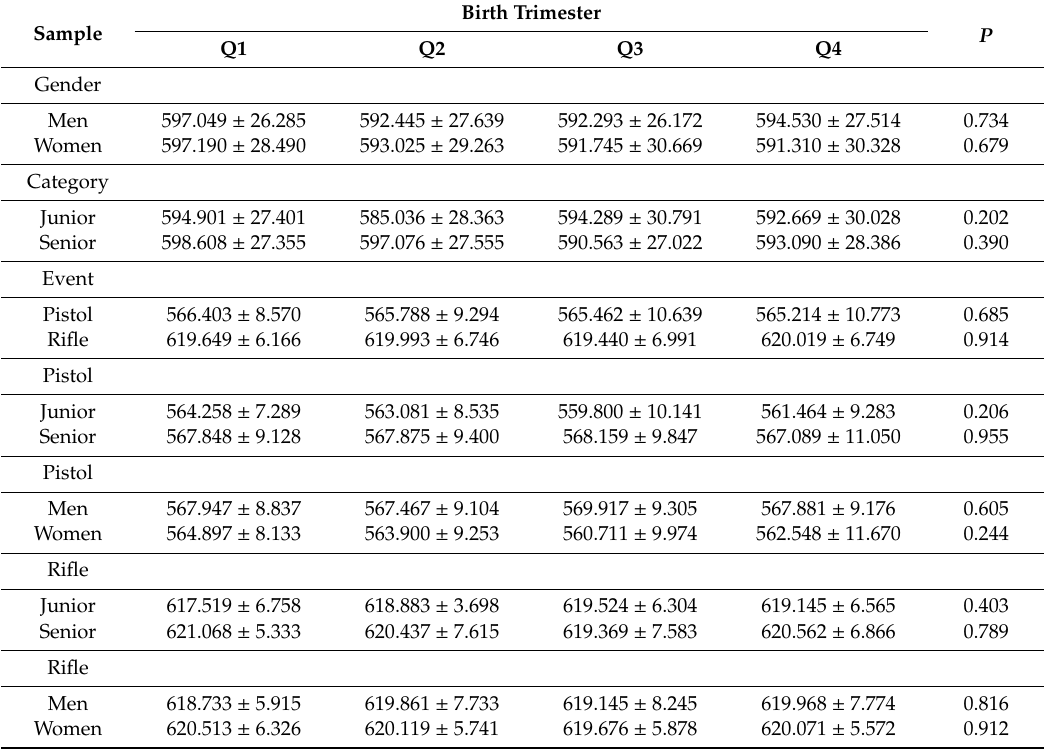
Table 5. Performance contrasts by trimester of